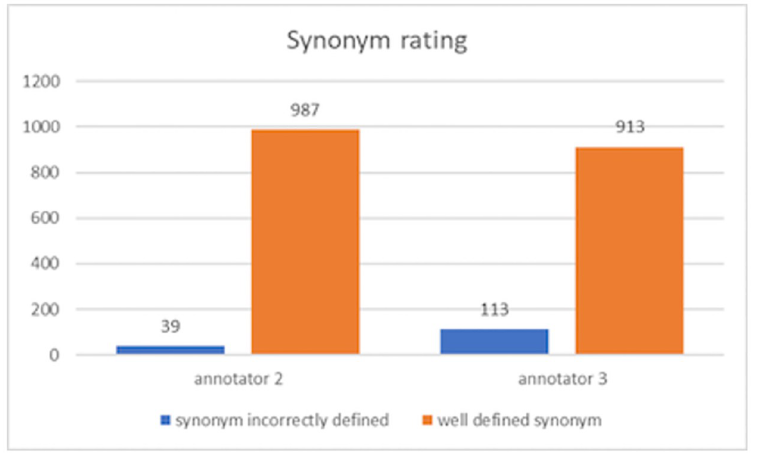
Fig 2. Annotations between annotator 2 and